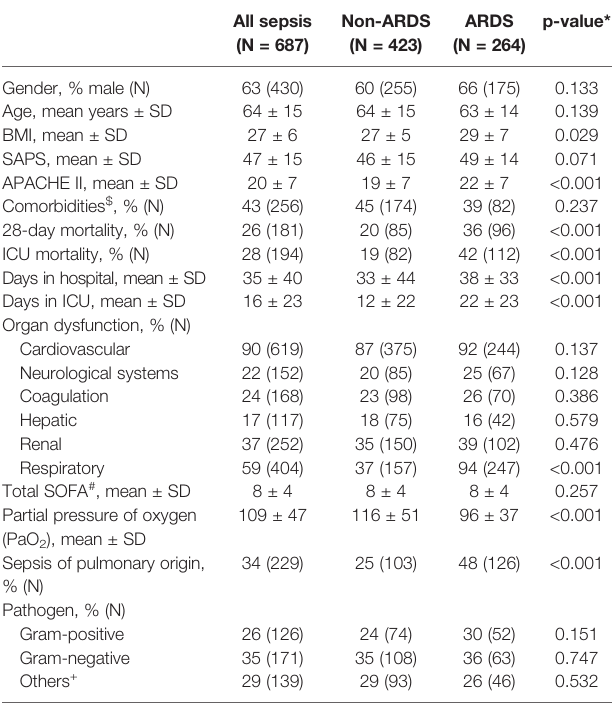
TABLE 1 | Demographic and clinical features among sepsis, non-ARDS, and ARDS related to sepsis cases from the GEN-SEP study. All sepsis (N =